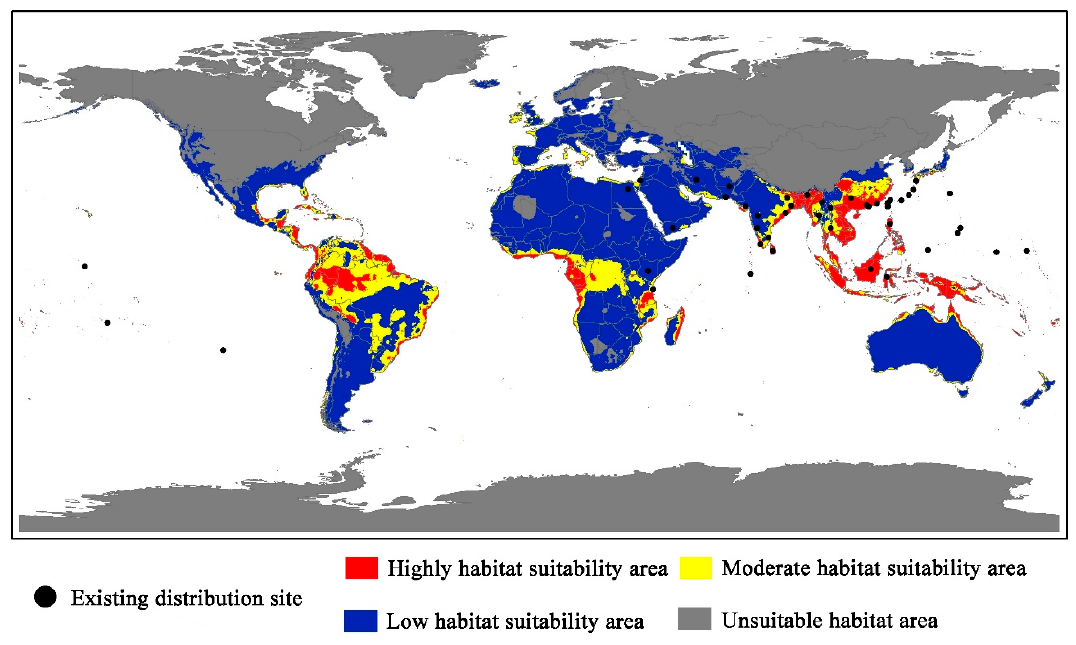
Figure 5. Potential geographical distribution of Icerya aegyptiaca on global scale in current climate modeling.